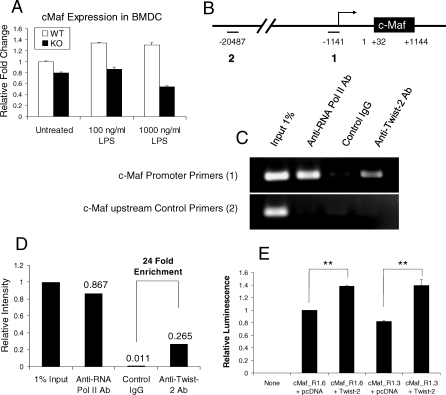
Twist-2 Is an Activator of c-Maf and Essential for Endotoxin Tolerance(A) Quantitative RT-PCR of relative c-Maf mRNA levels in Twist-2 KO and WT BMDCs with or without LPS stimulation from three independent experiments.(B–D) Schematic diagram of c-Maf promoter region and locations of primer pairs: (1) spanning a highly conserved region of the c-Maf promoter containing multiple E-box consensus sites, and (2) spanning a “promoter desert” region of genomic DNA approximately 20 kb upstream of the c-Maf promoter used for the ChIP assay (B). ChIP of 3T3 fibroblasts using an anti–Twist-2 antibody probing for c-Maf promoter DNA pulldown or an anti-RNA Poly (positive) or IgG (negative) controls (C) from one representative of two repeated experiments. Primer sequences available upon request. Densitometric analysis of relative ChIP PCR band intensity (upper panel) was normalized to input (D).(E) Activation of c-Maf promoter by Twist-2. COS7 cells were cotransfected with cMaf promoter-driven luciferase vectors containing approximately 1.6 kb (cMaf_R1.6) or 1.3 kb (cMaf_R1.3) of the rat cMaf promoter region [51] and Twist-2 or empty vector (pcDNA3.1) for 32 h before analyzing for luciferase activity. Double asterisks (**) indicate p < 0.01